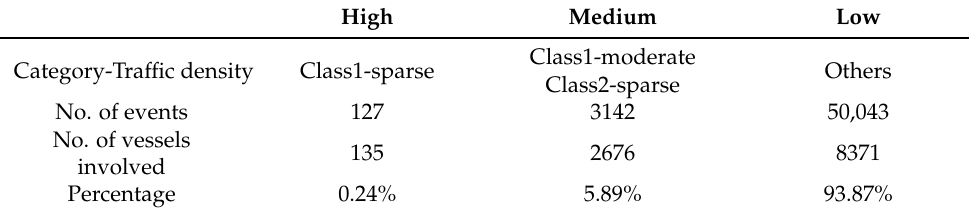
Table 10. Classify suspicion level for Rizhao, China validation